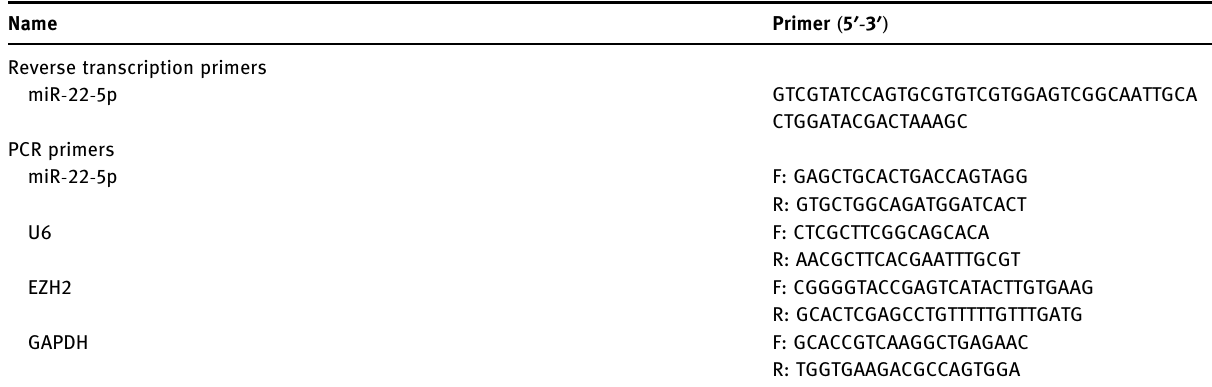
Table 1: Primer sequences used in miRNA reverse transcription and PCR